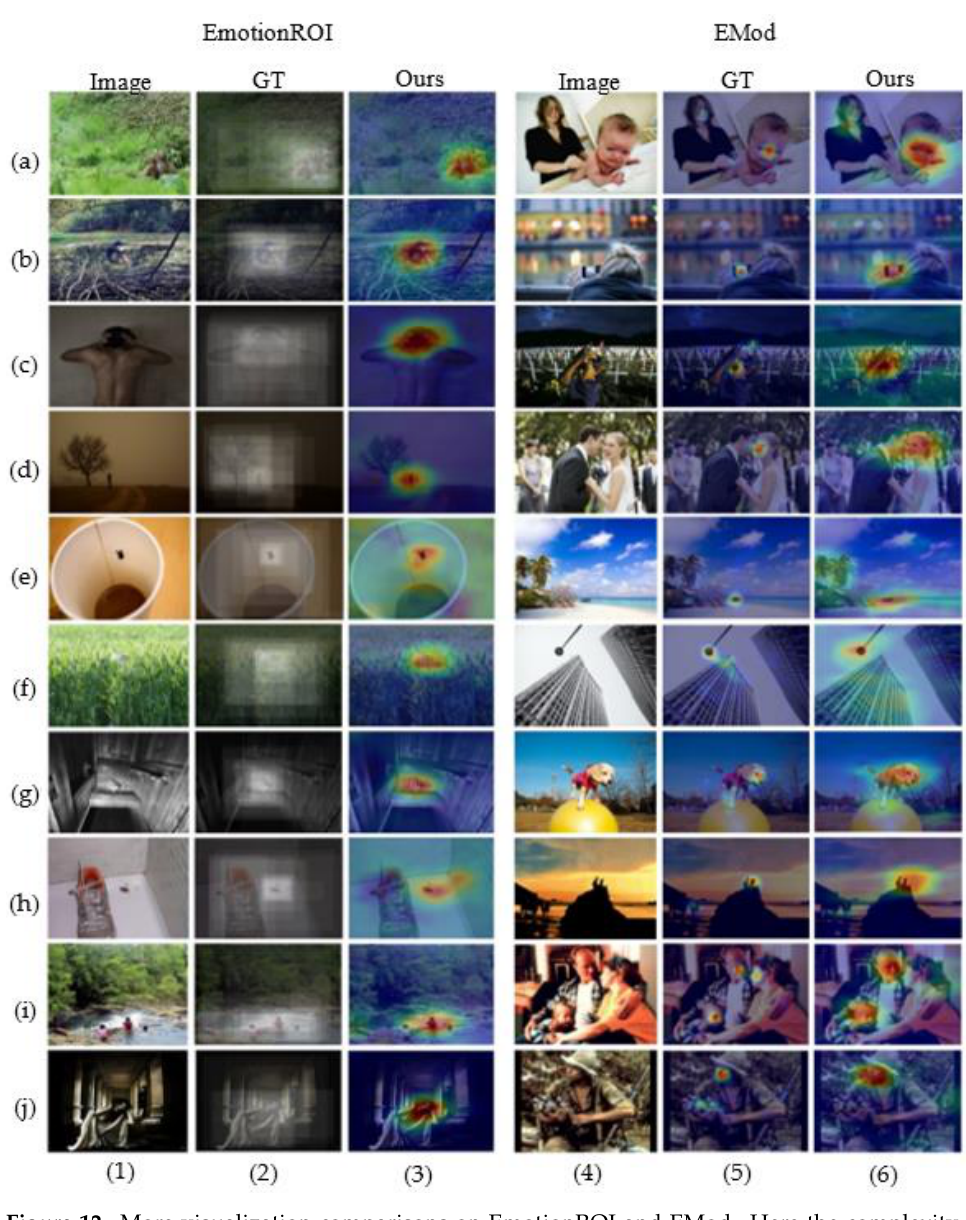
Figure 12. More visualization comparisons on EmotionROI and EMod. Here the complexity of appearance change varies appearance change varies with different objects. For the small-sized objects, such as (f1) birds in with different objects. For the small-sized objects, such as (f1) birds in grass, (g1) masks on chairs, (b1, i1, h4) people, their grass, (g1) masks on chairs, (b1, i1, h4) people, their appearance and surroundings are quite different. appearance and surroundings are quite different. Since our model is not trained on these two datasets, the comparisons Since our model is not trained on these two datasets, the comparisons on these two datasets are fairly. on these two datasets are fairly. GT is the ground truth. GT is the ground